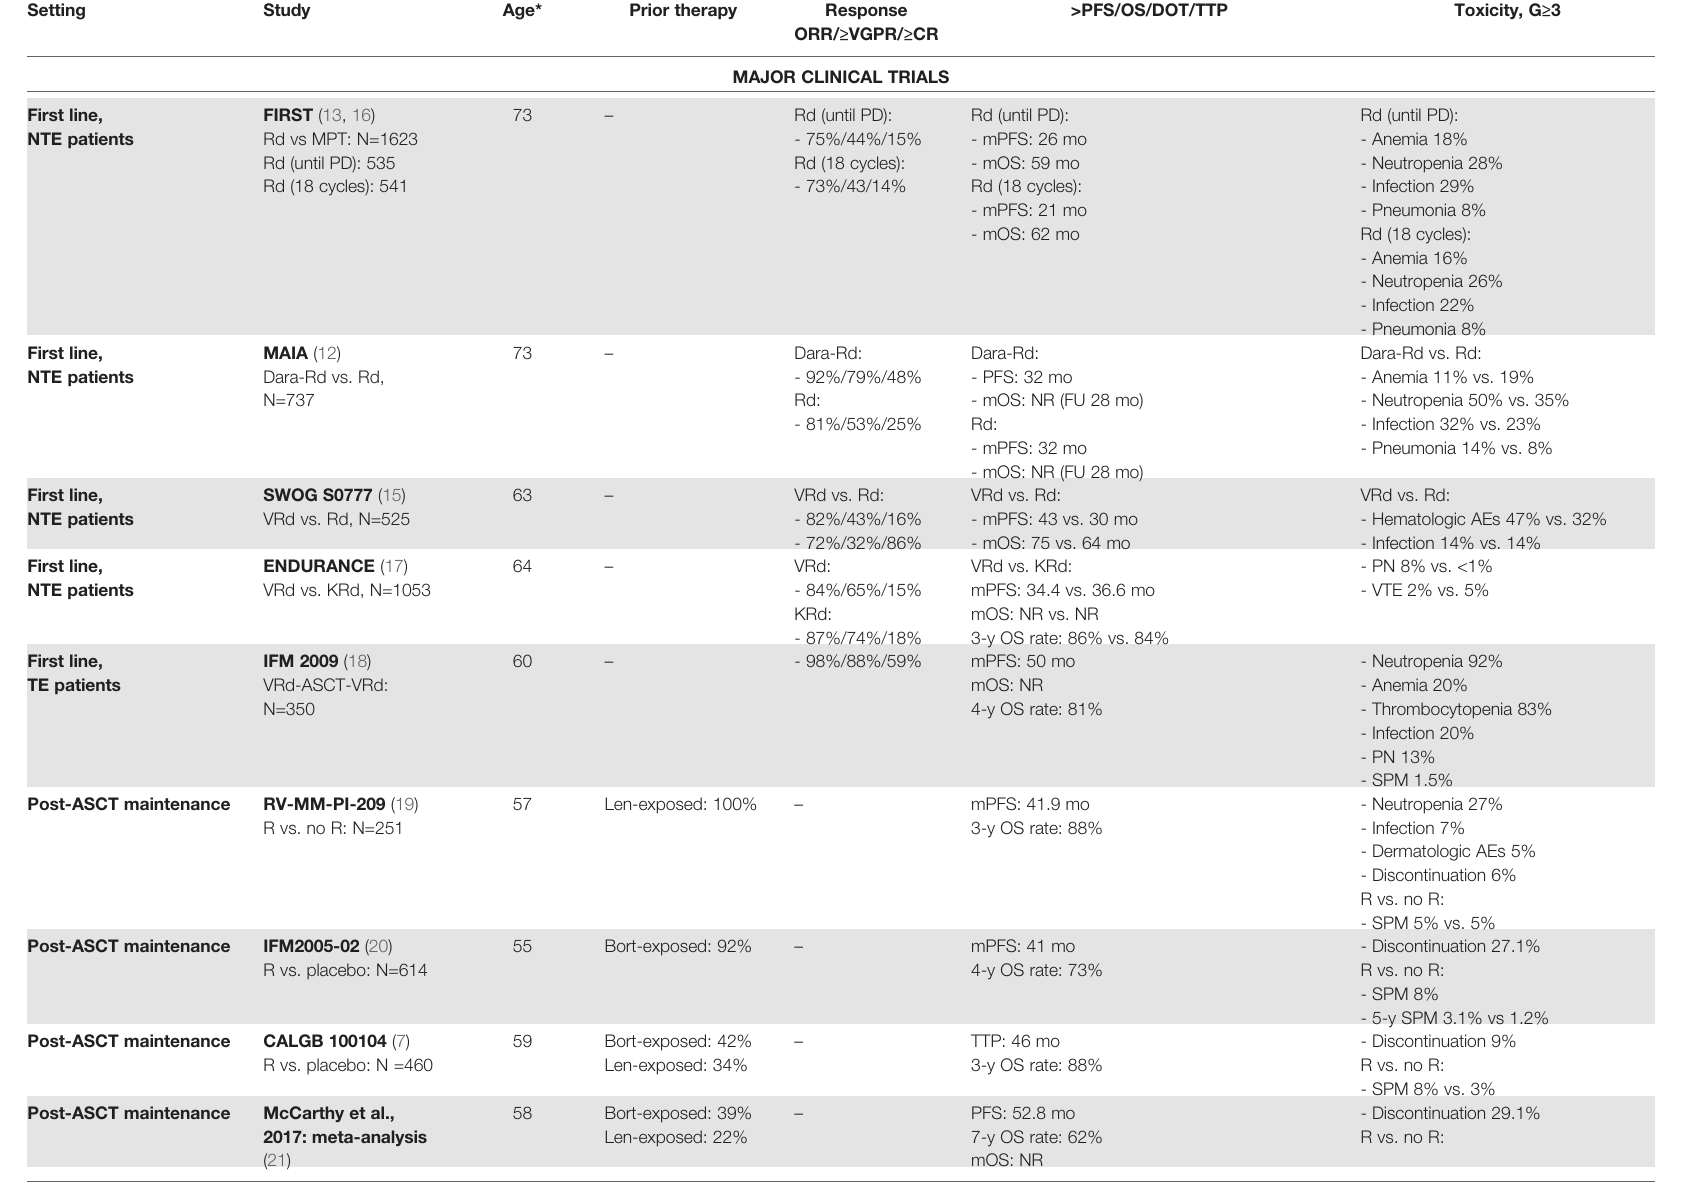
TABLE 1 | Major clinical trials and real-world studies based on lenalidomide in fi rst-line treatment.